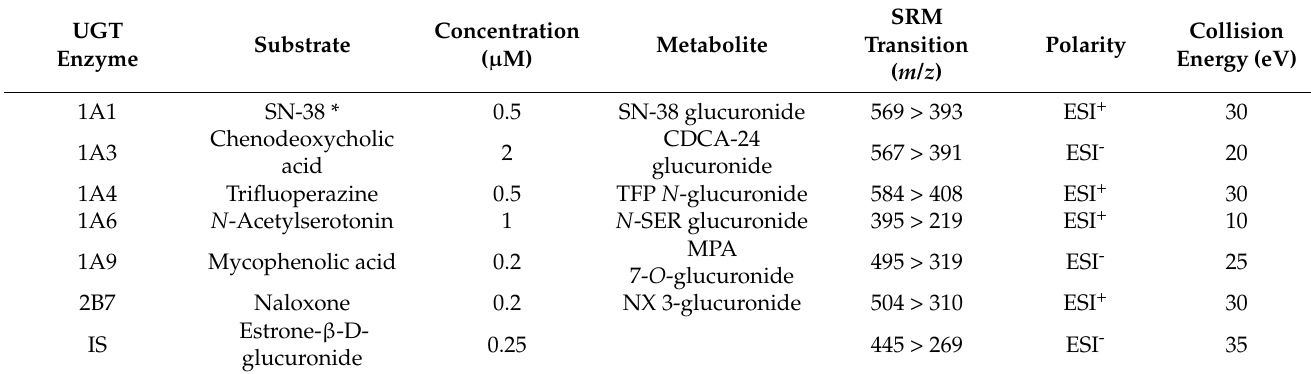
Table 2. Optimized selected reaction monitoring (SRM) parameters for the metabolites of the six UGT substrates and internal standard (IS).